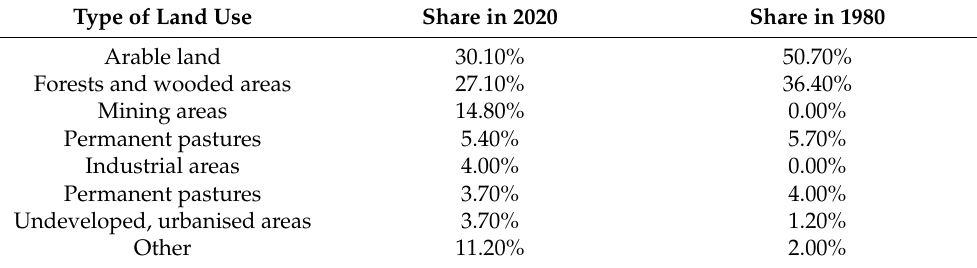
Figure 6. Be ł chatów open pit area in 1984 ( left ), and in 2018 ( right ) (source: own elaboration). Table 7. Land use structure in the municipality of Kleszcz ó w.